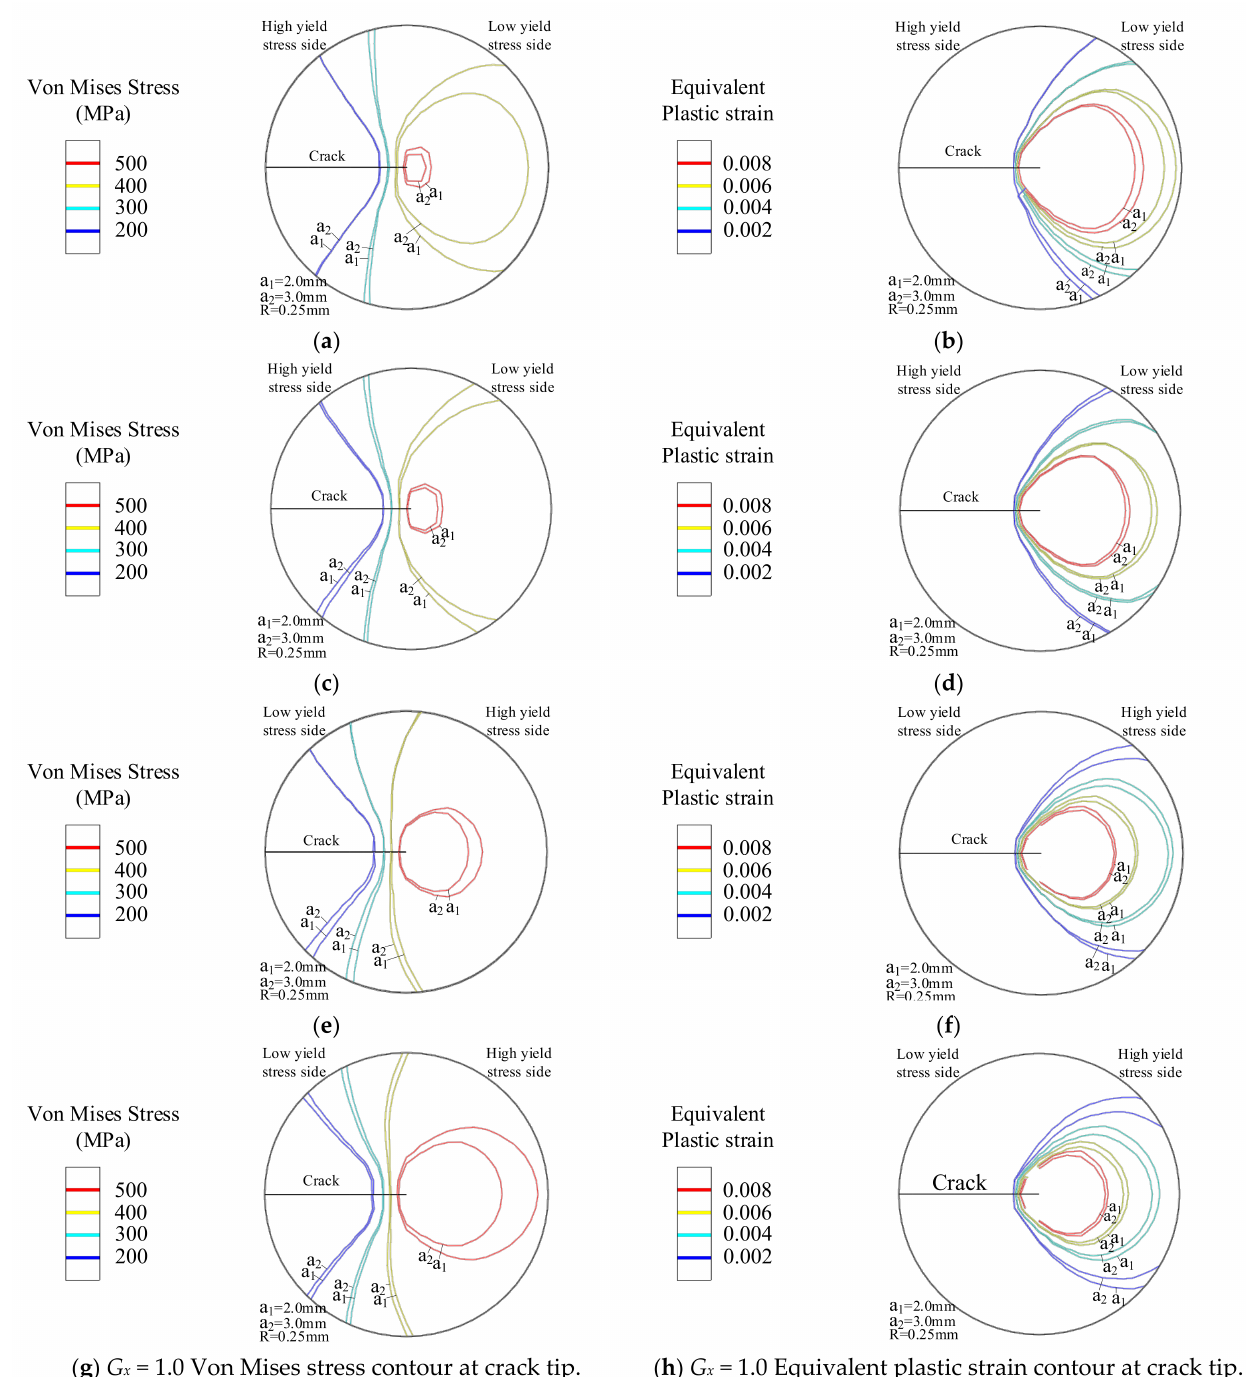
Figure 14. The static crack tip mechanical field with different lengths in the x -direction of the yield strength. ( a ) G x = − 1.0 Von Mises stress and ( b ) Equivalent plastic strain contour. ( c ) G x = − 0.5 Von Mises stress and ( d ) Equivalent plastic strain contour. ( e ) G x = 0.5 Von Mises stress and ( f ) Equivalent plastic strain contour. ( g ) G x = 1.0 Von Mises stress and ( h ) G x = 1.0 Equivalent plastic strain